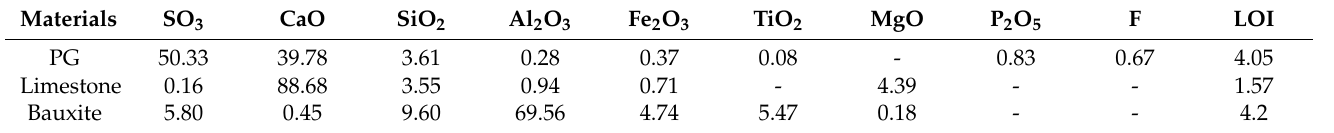
Table 1. Chemical compositions of the materials